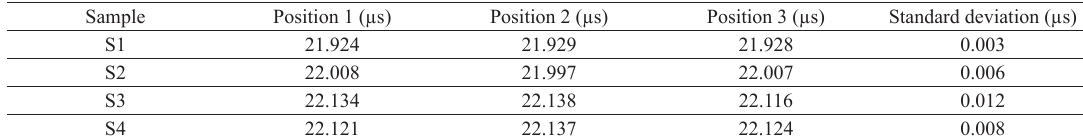
Table 3. Time of flight (µs) of the LCR wave in samples with fiber waviness.